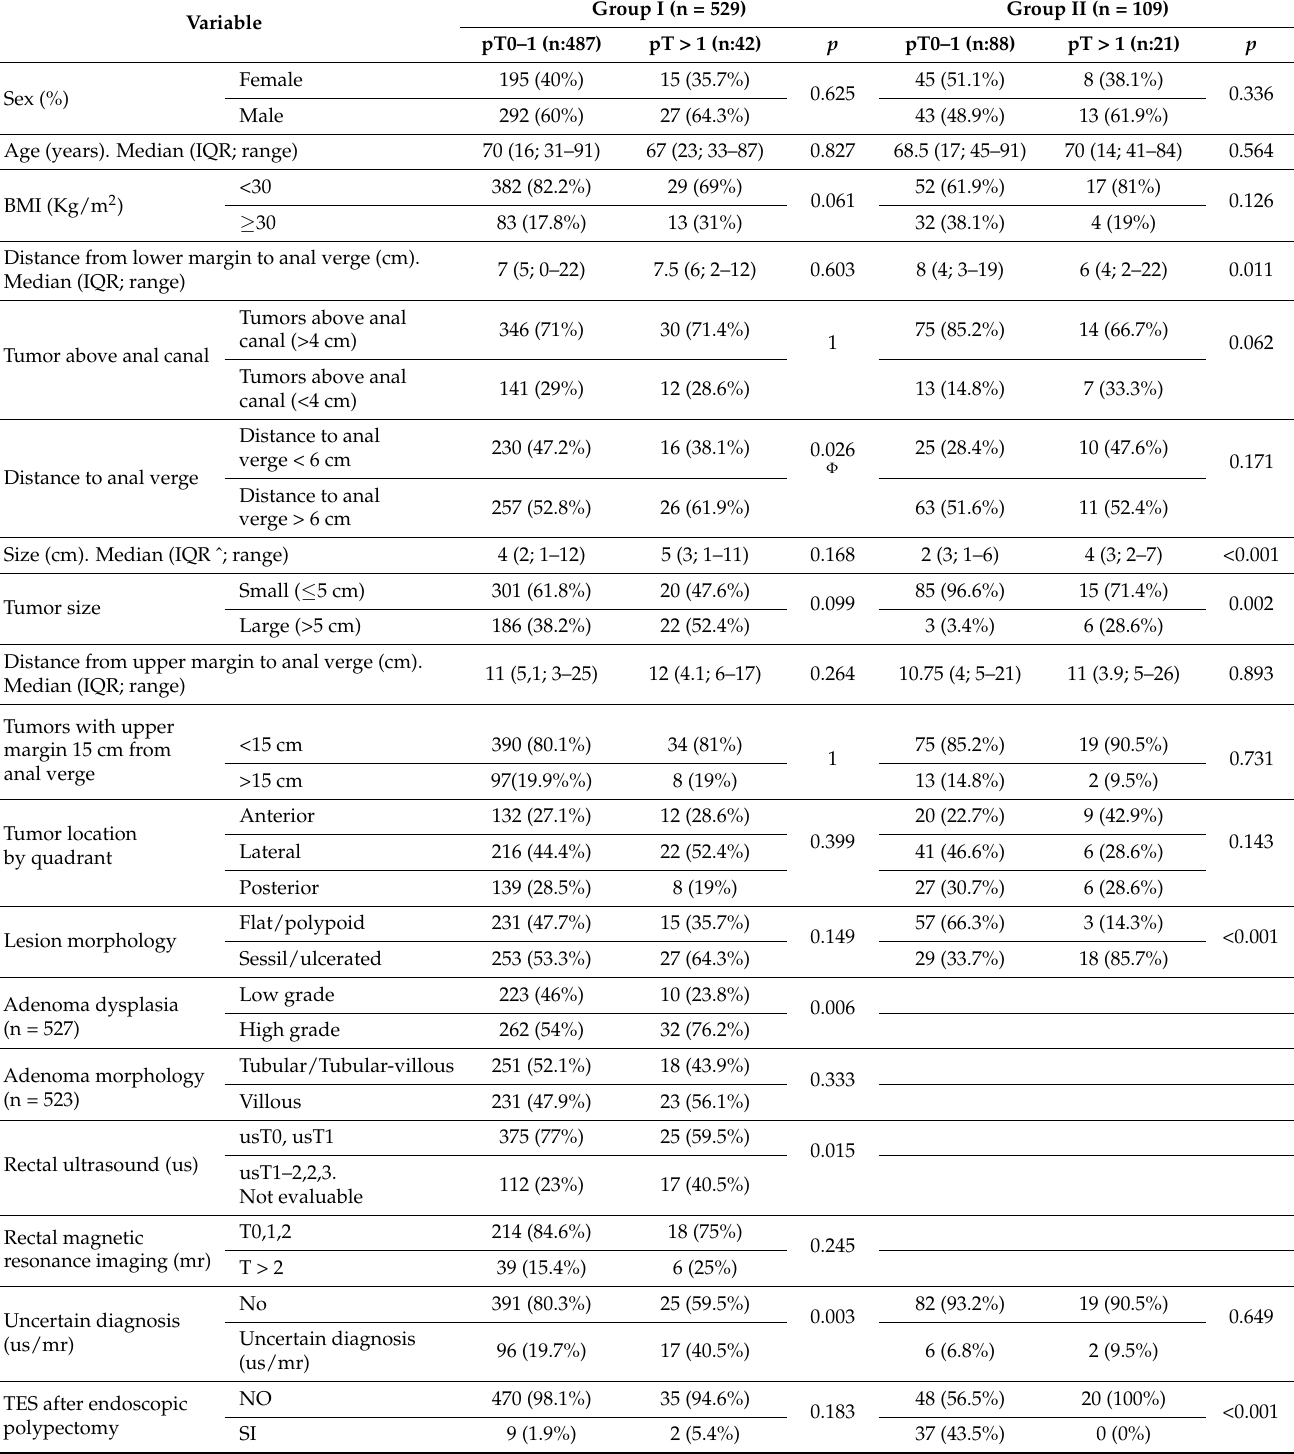
Table 4. Univariate analysis of patients in groups I and II regarding the pathological variable of rectal cancer